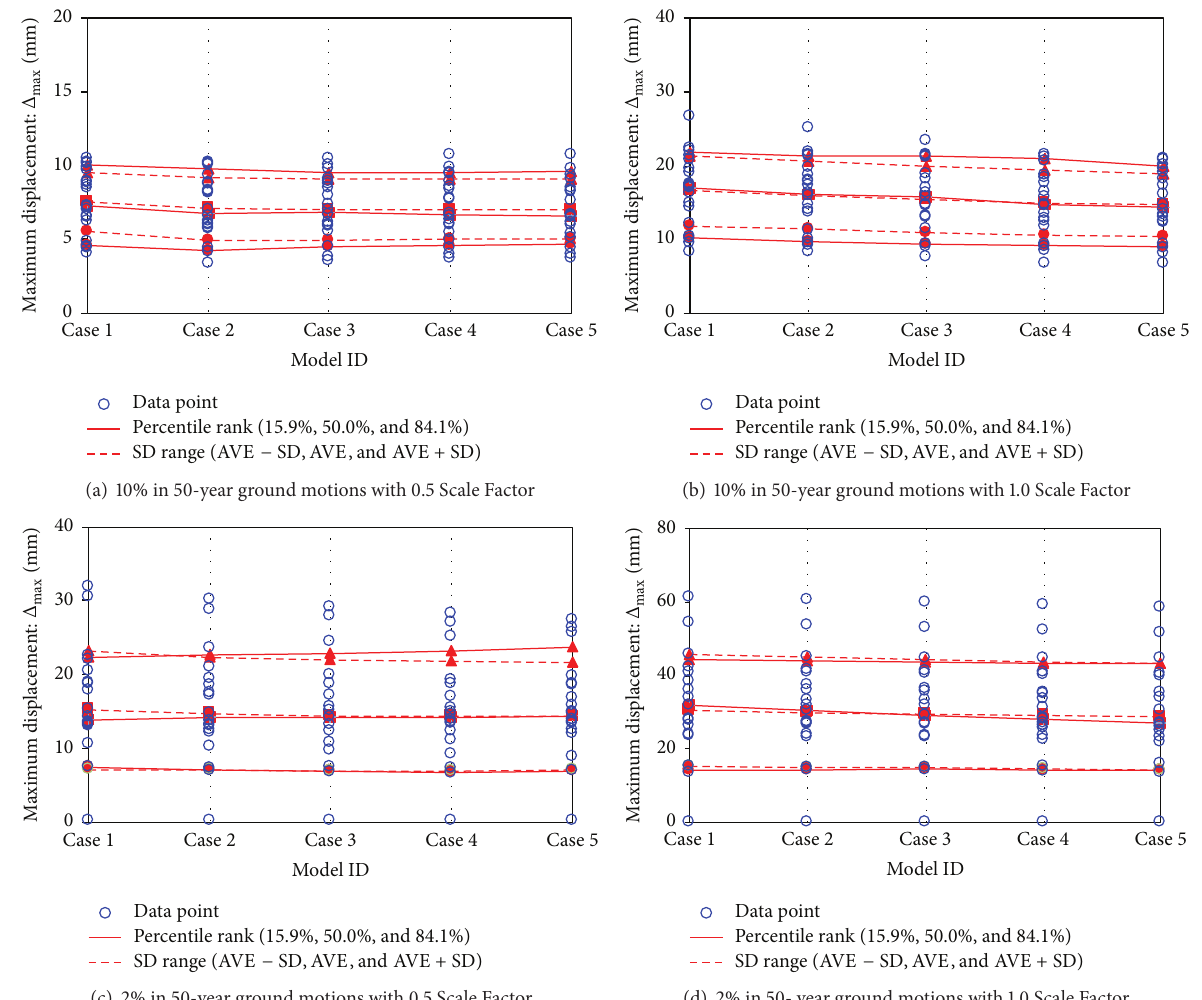
Figure 12: Maximum displacement ( Δ max ) for individual SFDB models under 40 ground motions with different SFs.